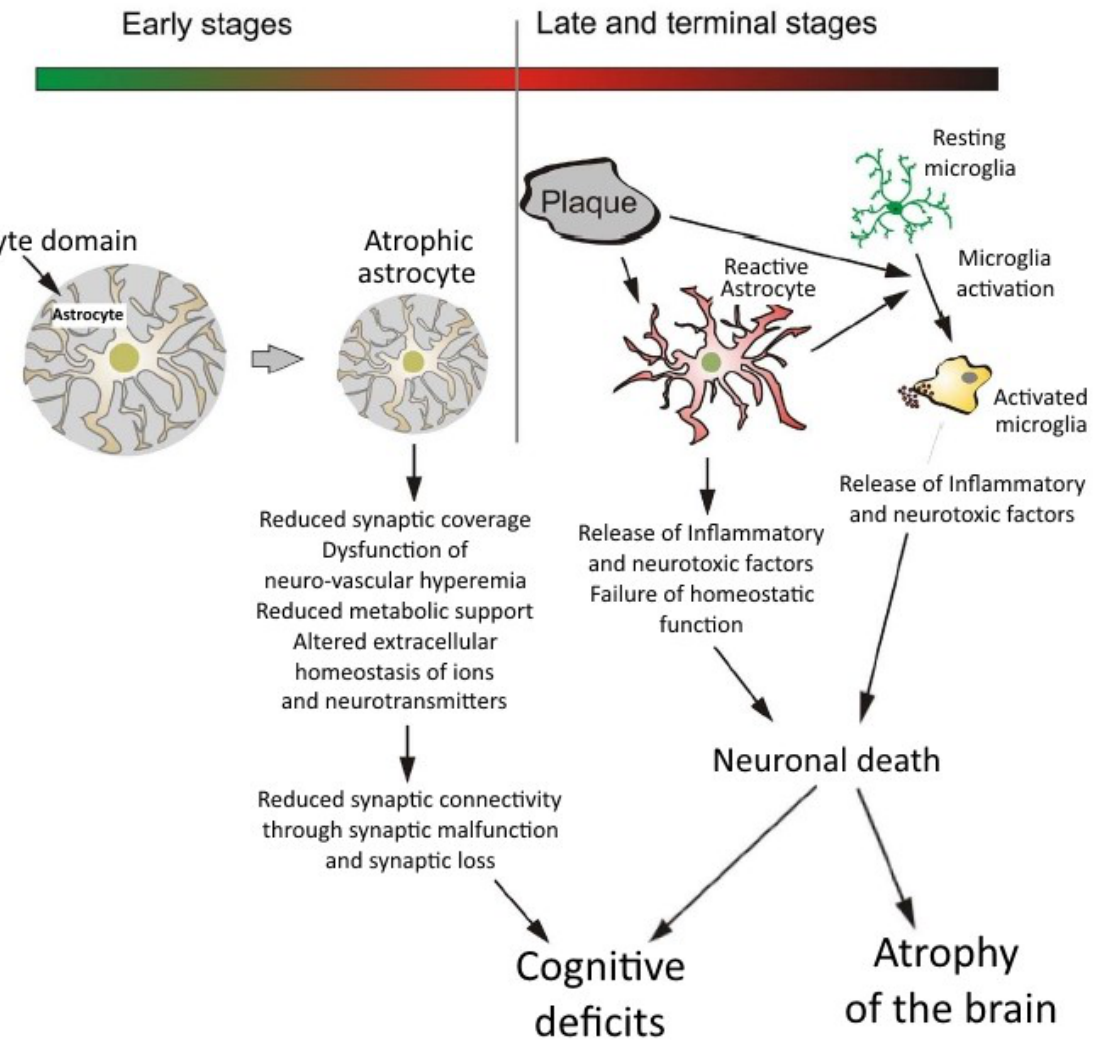
Figure 4: Pictorial representation of cell processes during Alzheimer disease